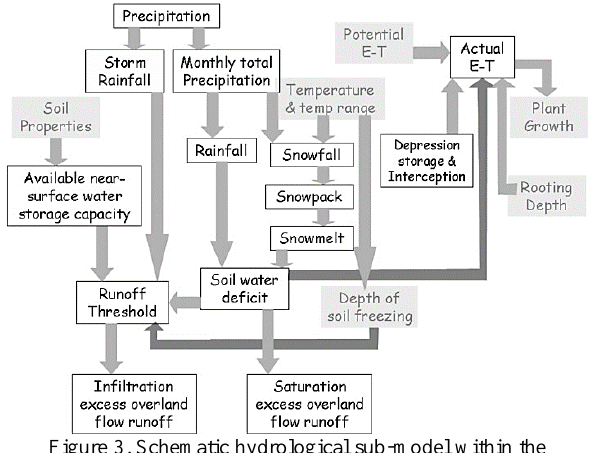
Figure 3. Schematic hydrological sub-model within the PESERA model (Kirkby et al. 2010).